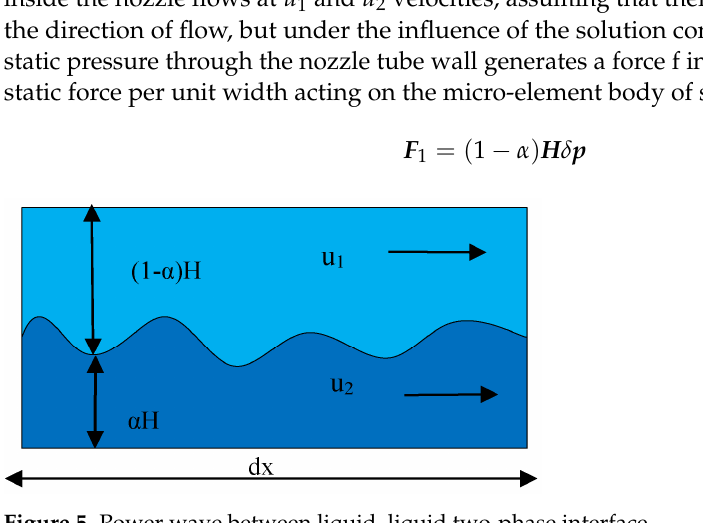
Figure 5. Power wave between liquid–liquid two-phase interface.